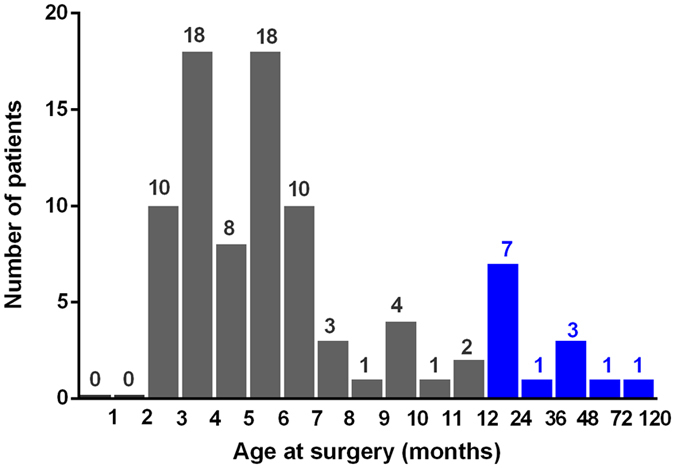
The distribution of included CC patients with different age periods.Nearly 85.2% (75/88) of the included CC patients were younger than 1 year old.